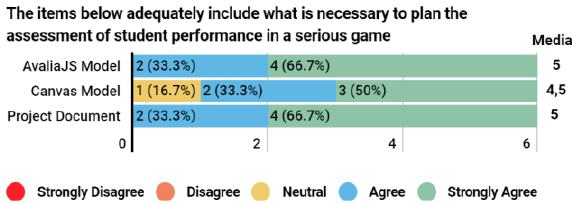
Figure 10. Experts’ answers regarding the flexibility (item 8) of the AvaliaJS